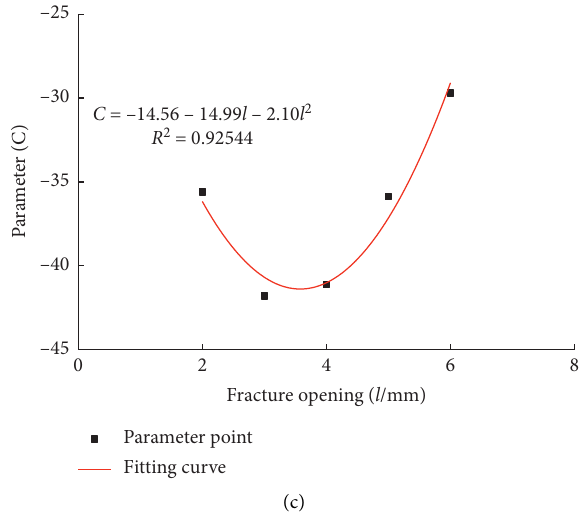
Figure 11: Curve of the relationship between the level of the fracture and the fitting parameters: (a) Parameter A, (b) Parameter B, and (c) Parameter